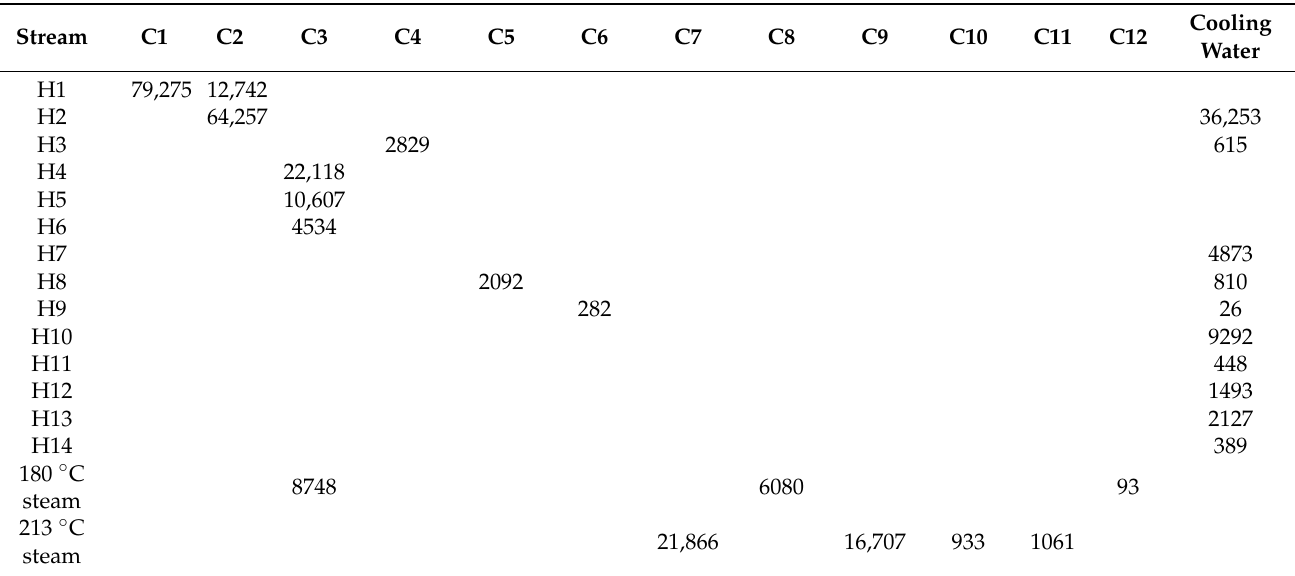
Table 3. Existing HEN of the EG process.